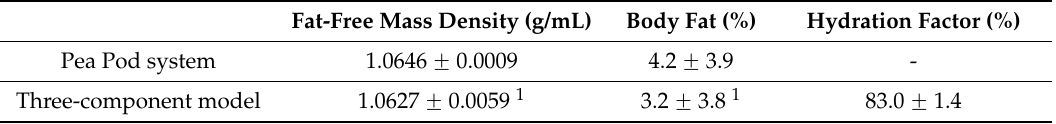
Table 3. Fat-free mass density and body fat of 14 moderately premature infants, 3–7 days old, assessed using the Pea Pod system or using a three-component model. The hydration factor is also